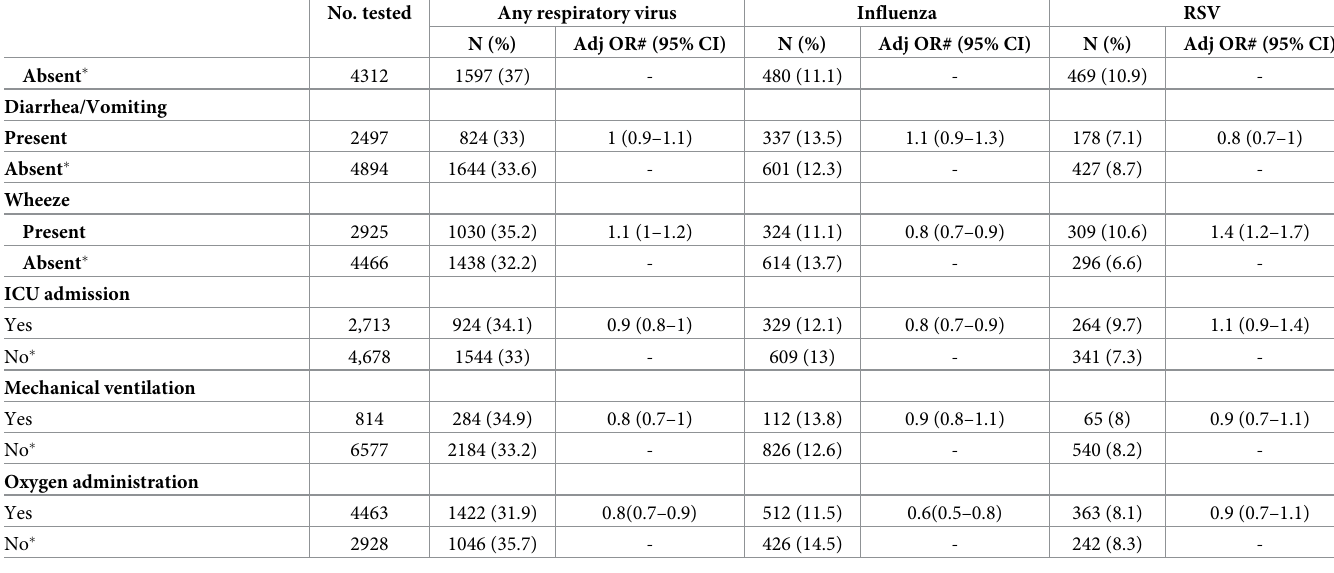
Hemisphere vaccine component. Phylogenetic analysis of HA gene of influenza B Yamagata (n = 12) isolates were grouped in Y3 Phuket clade and influenza B Victoria (n = 19) isolates grouped in V1a clade, which were similar to B/Phuket/3073/2013 and Colorado/06/2017 vac- cine components